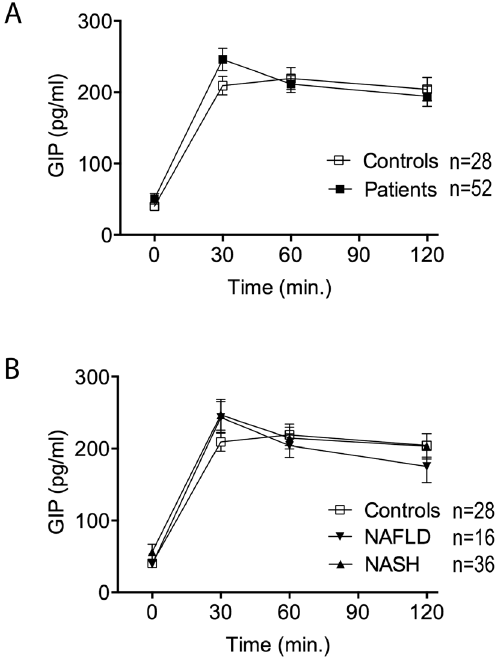
Figure 2. Glucose-dependent insulinotropic polypeptide (GIP) secretion in response to oGTT. (A) GIP secretion in response to oGTT is not different in patients vs. controls. Patients n=52; controls n=28. (B) GIP secretion in NAFLD and NASH vs. controls. NAFLD n=16; NASH n=36; controls n=28. GIP (pg/ml) is expressed as mean 6 SEM.